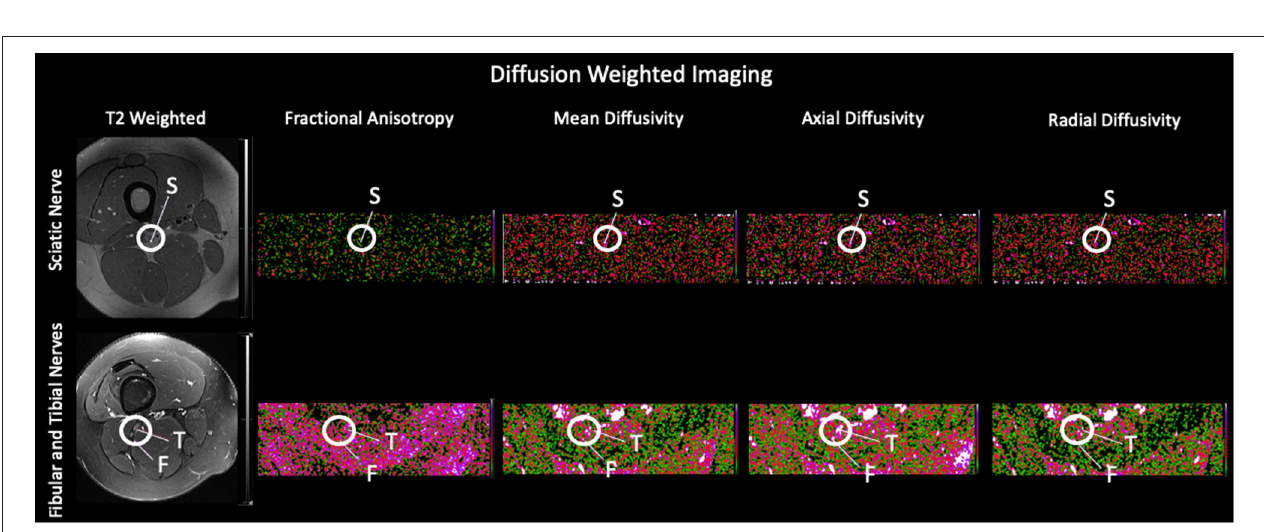
FIGURE 1 | Field of view. Images of an exemplar subjects are shown demonstrating the field of view taking from the anterior-posterior and medial-lateral position. Yellow box indicates the field of view of the diffusion and MTR analyses that contains the three nerve divisions evaluated. For each nerve division, we performed slice-wise regions of interest that were drawn on axial slices.